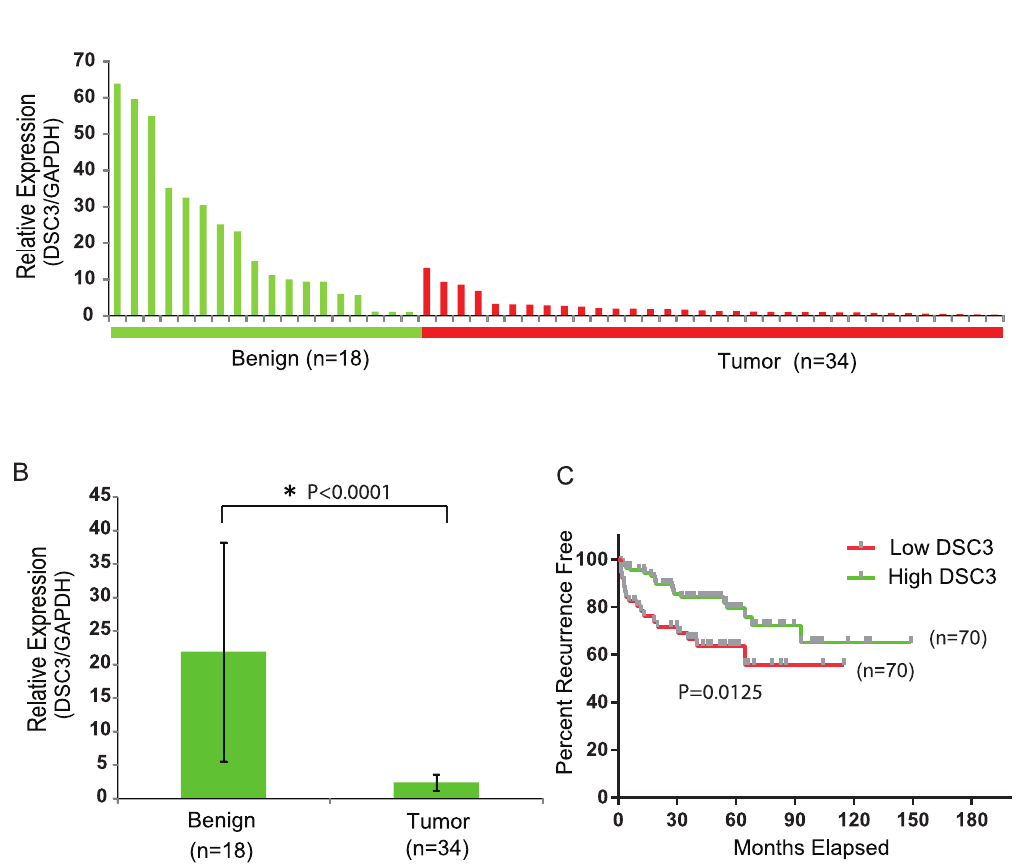
Figure 4. DSC3 is mRNA is Down-regulated in an Independent PCa Cohort and its Expression Correlates with Biochemical Recurrence. (A) Q-PCR for DSC3 transcript in a cohort of benign prostate (n=18) and prostate cancer (n=34) tissues. (B) A summary histogram of the expression values of DSC3 in prostate benign and tumor samples. (C) Kaplan-Meier analysis showed that low DSC3 group patients had a significantly increased risk of recurrence than the high DSC3 group patients (P=0.0125).